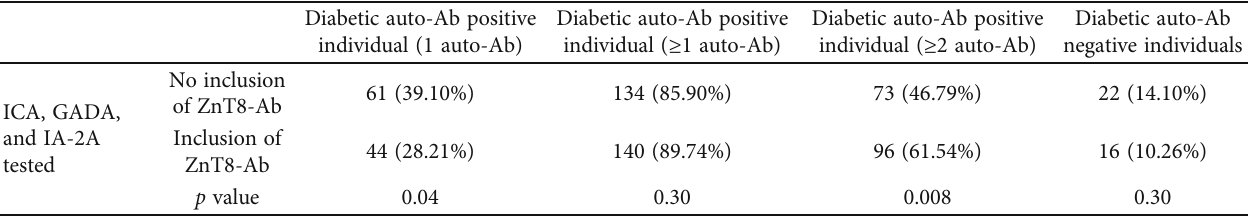
Figure 1: Venn diagrams showing the prevalence and overlap between the prevalence of ICA, GADA, IA-2A, and ZnT8-Ab in type 1 diabetic children. Data showed the number of positive T1D patients. ZnT8-Ab: zinc transporter 8 antibodies; GADA: glutamic acid Table 2: The e ff ect of the inclusion of ZnT8-Ab assays in the panel of routinely auto-Abs on the sensitivity for beta-cell autoimmunity in type 1 diabetes (T1D) newly diagnosed